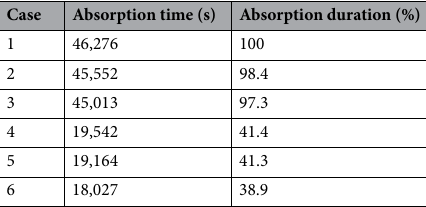
Table 5. Summary of hydrogen absorption times for all six cases. (The percentage of hydrogen absorption duration is calculated based on the absorption time from case 1).